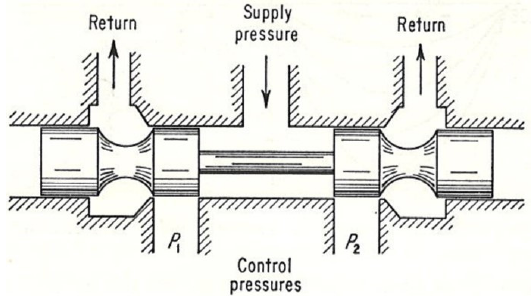
Figure 1. Schematic diagram of spool valve [6].